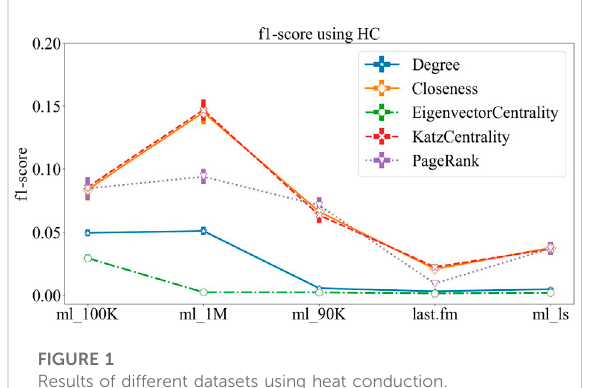
FIGURE 3 Recommendation results of fi ve datasets using hybrid